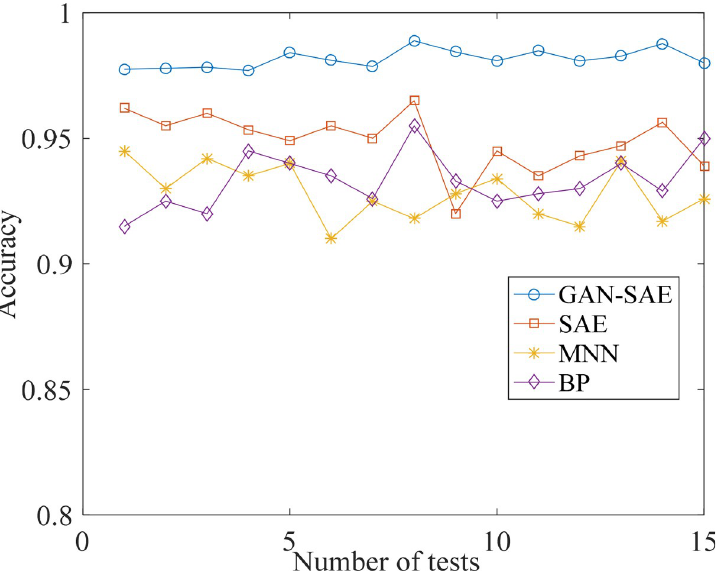
Fig 13. Diagnostic accuracy of the 15